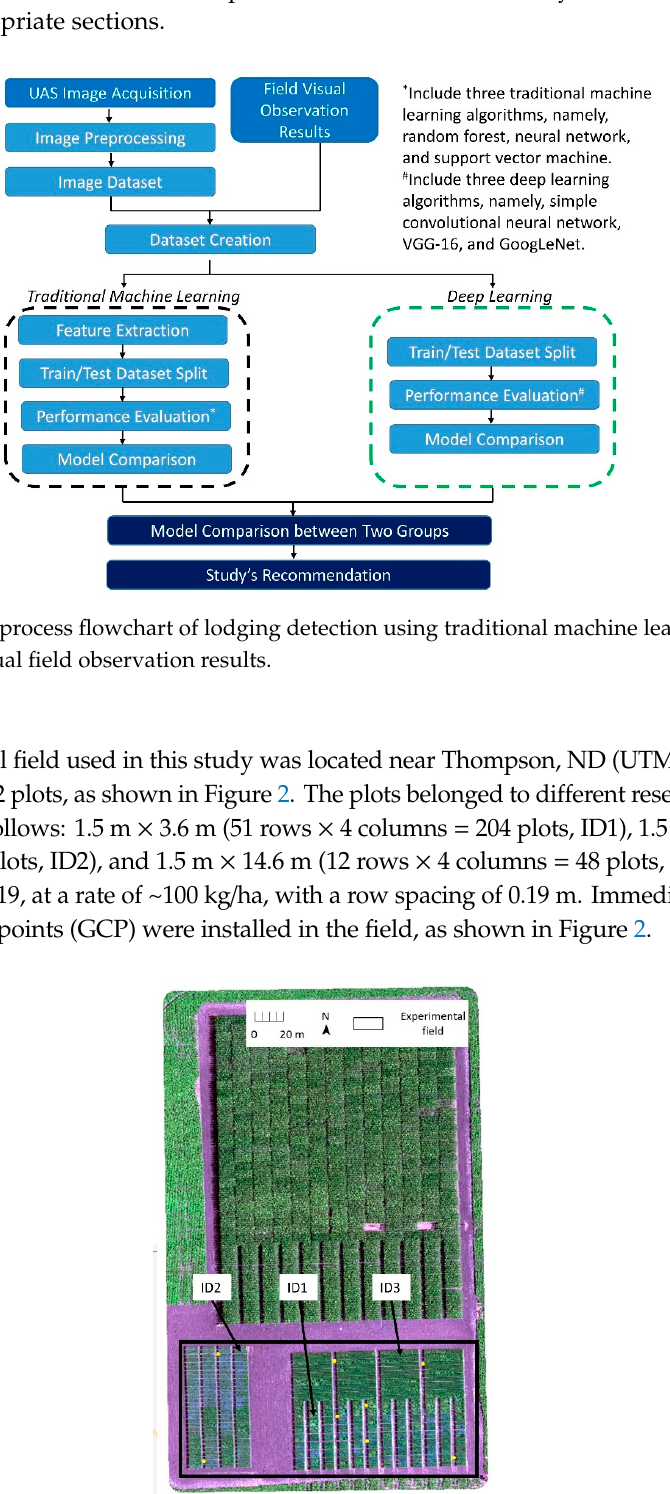
Figure 2. Location and details of the experimental wheat field layout established near Thompson County, ND (UTM WGS 84 14 N), USA with pre-installed control points. ID1, ID2, and ID3 are identification numbers of research field blocks of 204, 120, and 48 plots of di ff erent